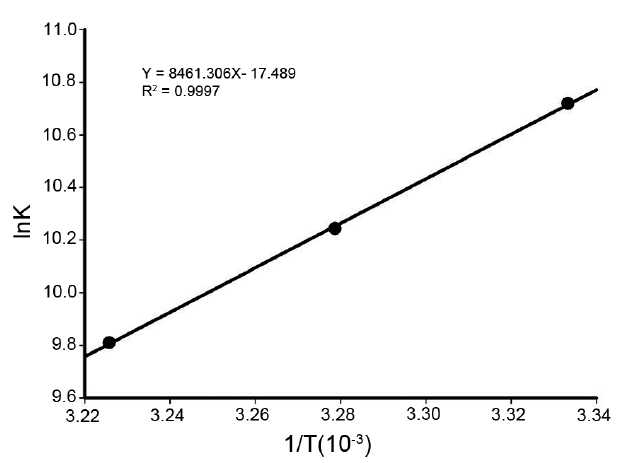
Figure 6. Van’t Hoff plot used to predict the interaction between HSA and Dp44mT as described